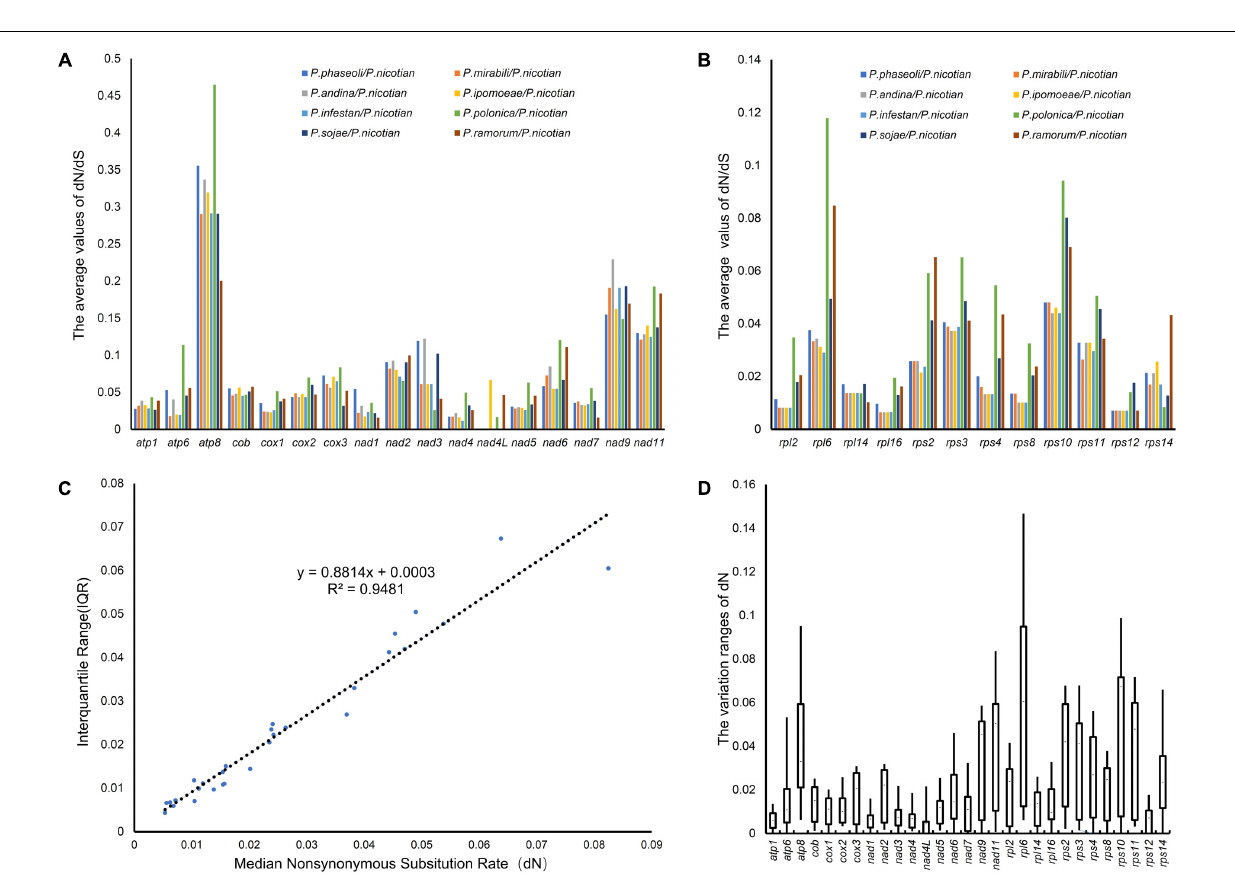
Frontiers in Microbiology |